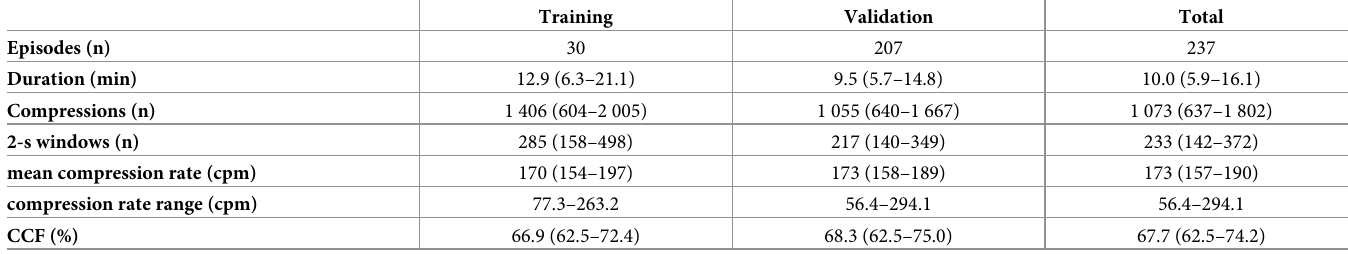
Table 1. Characteristics of the database (derived from the